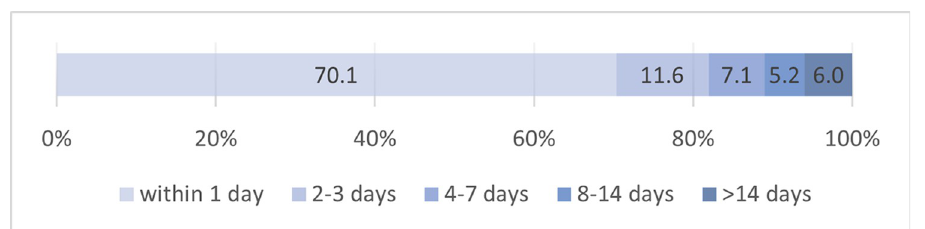
Fig 2. Period between pre- and post-assessment by proportion of completers (N =